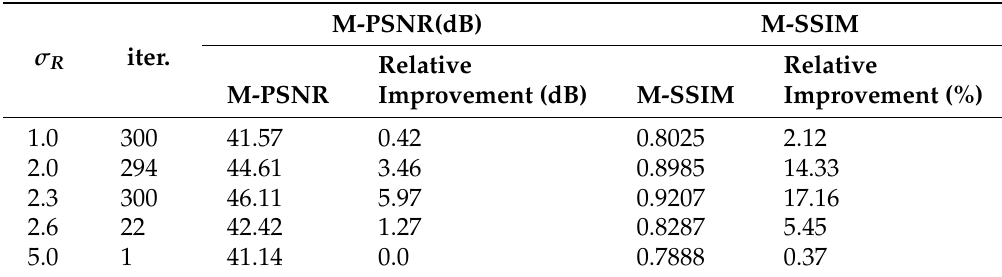
Figure 10. Visual accelerated RL deconvolution results with varying kernel coefficients. k indicates the number of RL deconvolution iterations. Table 2. M-PSNR and M-SSIM at the minimum M-RRE for different kernels running the standard RL deconvolution.